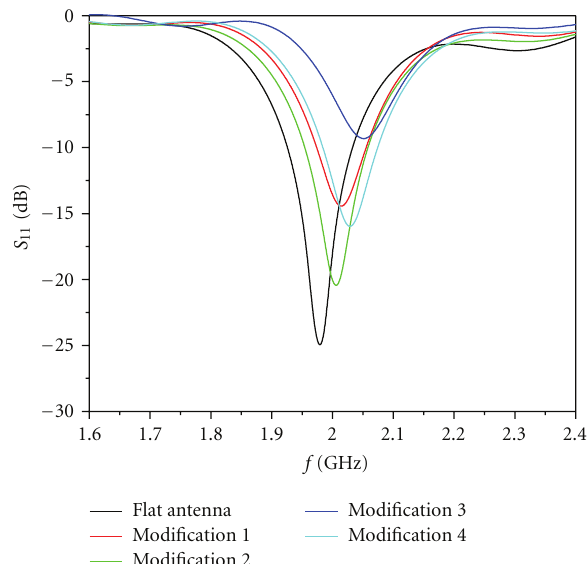
Figure 3: Simulated return loss for the proposed planar fractal antenna and its folded modifications.